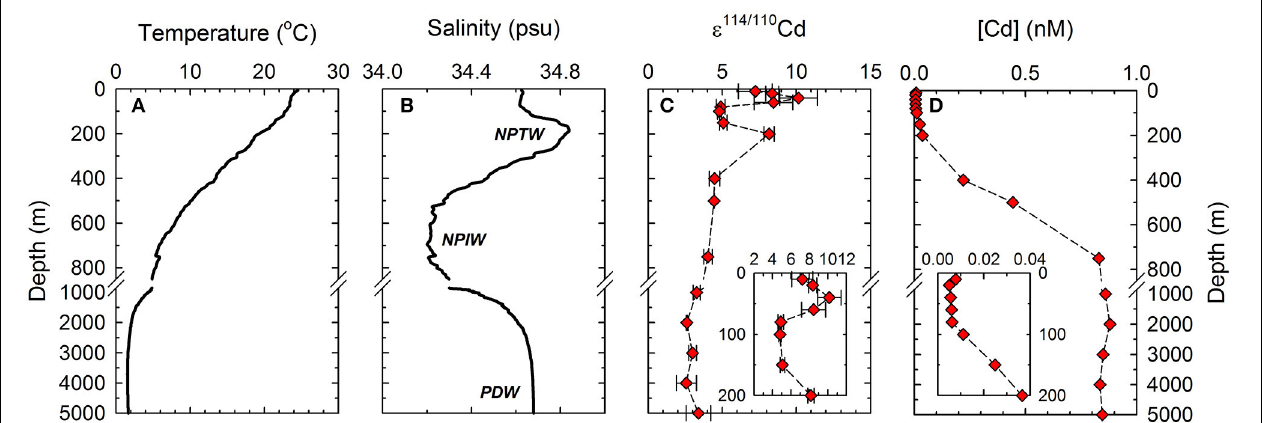
FIGURE 2 | Depth profiles of Cd concentrations, ε 114 / 110 Cd, temperature and salinity at the sampling site. (A) Temperature; (B) Salinity; (C) ε 114 / 110 Cd; (D) Cd concentrations. Abbreviations—Water masses: NPTW, North Pacific Tropical Water; NPIW, North Pacific Intermediate Water; PDW, Pacific Deep